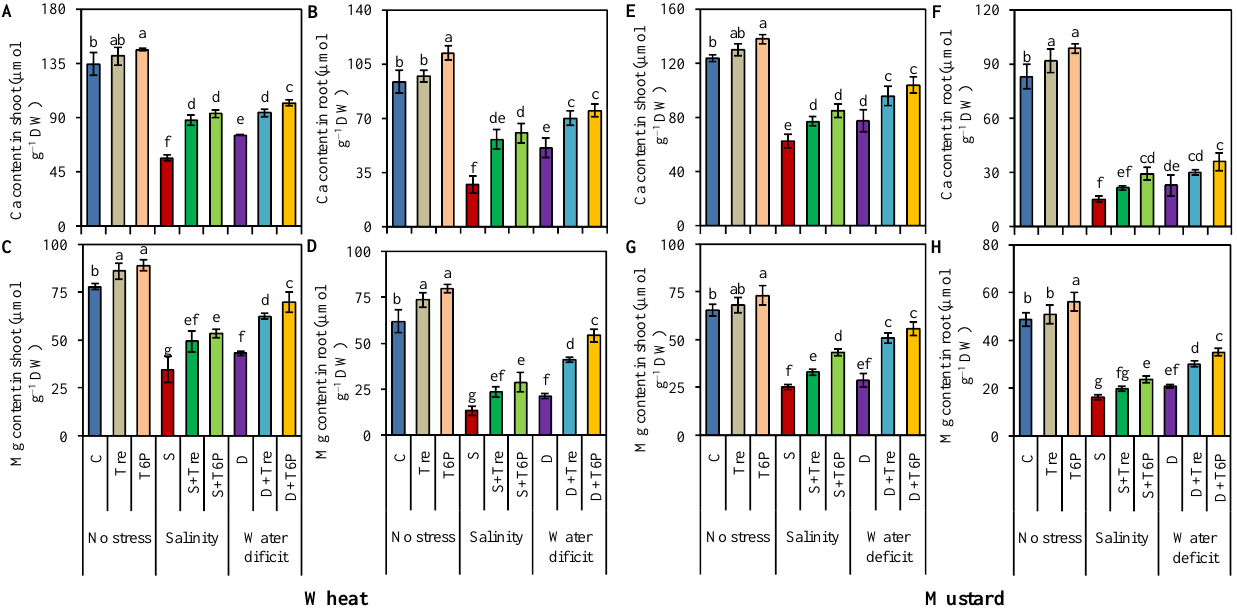
Figure 8. Effect of trehalose and T6P on the contents of Ca and Mg in shoots and roots of wheat and mustard seedlings. Wheat seedlings were grown in a hydroponic solution containing 300 mM NaCl for 9 days. Mustard seedlings were grown in 200 mM NaCl for 10 days. For water deficit treatment, wheat seedlings were treated with 20% PEG, while mustard was treated with 12% PEG for four days. C, control; ( A – D ) wheat; ( E – H ) mustard; Tre, 200 µ M trehalose; T6P, 200 µ M trehalose 6-phosphate; S, NaCl treatment; D, water deficit treatment with PEG 6000. Means were calculated from three replicates for each treatment, and the bars represent the standard deviation ( ± SD). Values with different letters are significantly different at p ≤ 0.05 by Fisher’s LSD test.